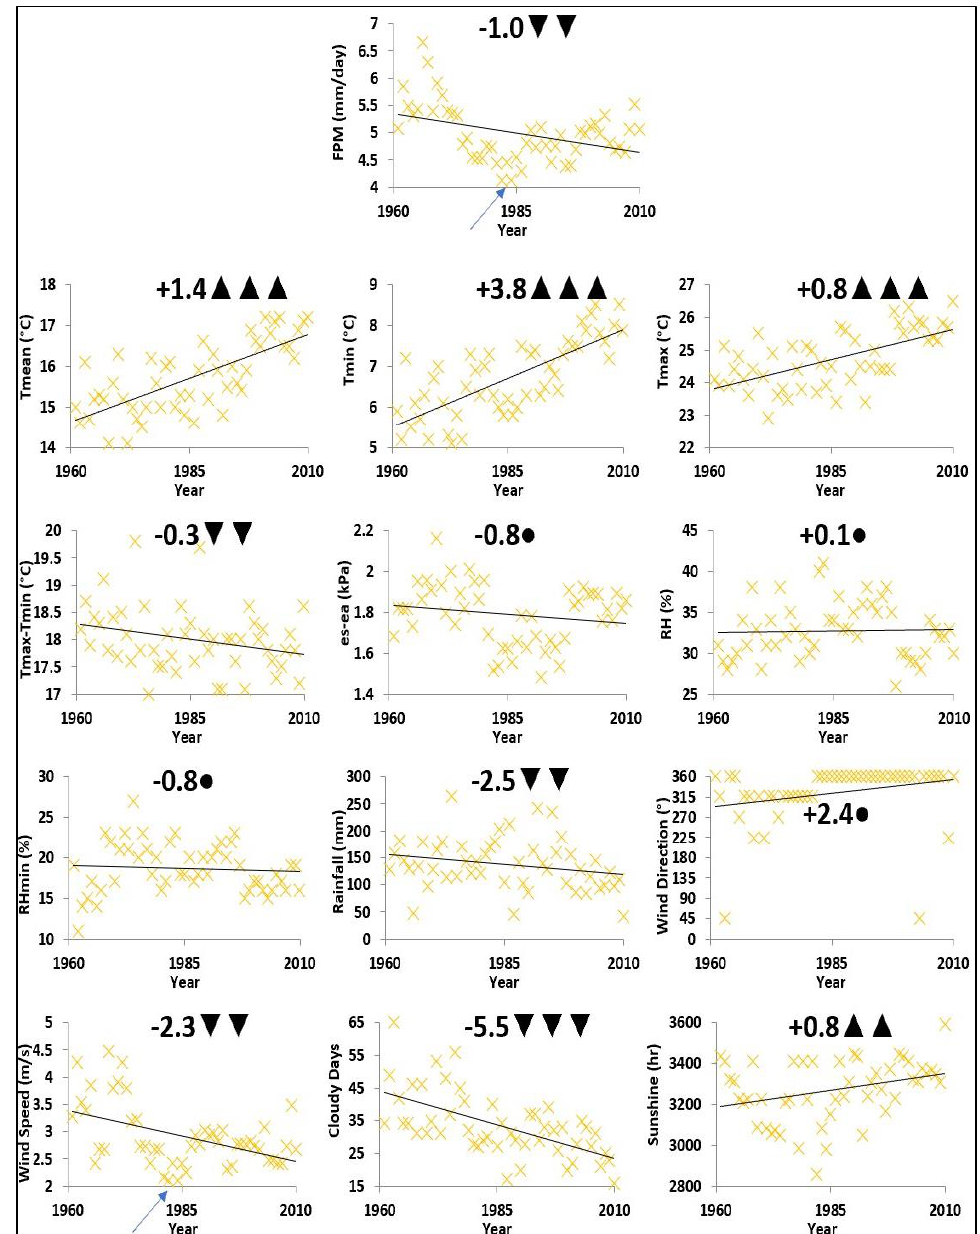
Figure 2. The 50-year (1960–2010) trends of annually averaged reference evapotranspiration and meteorological variables in Kerman. Circles indicate an insignificant trend. One, two, and three triangles indicate a significant trend at a confidence level of 90%, 95%, and 99%, respectively. The value on the left of triangular symbols shows the increasing/decreasing rate over the 50-year period.